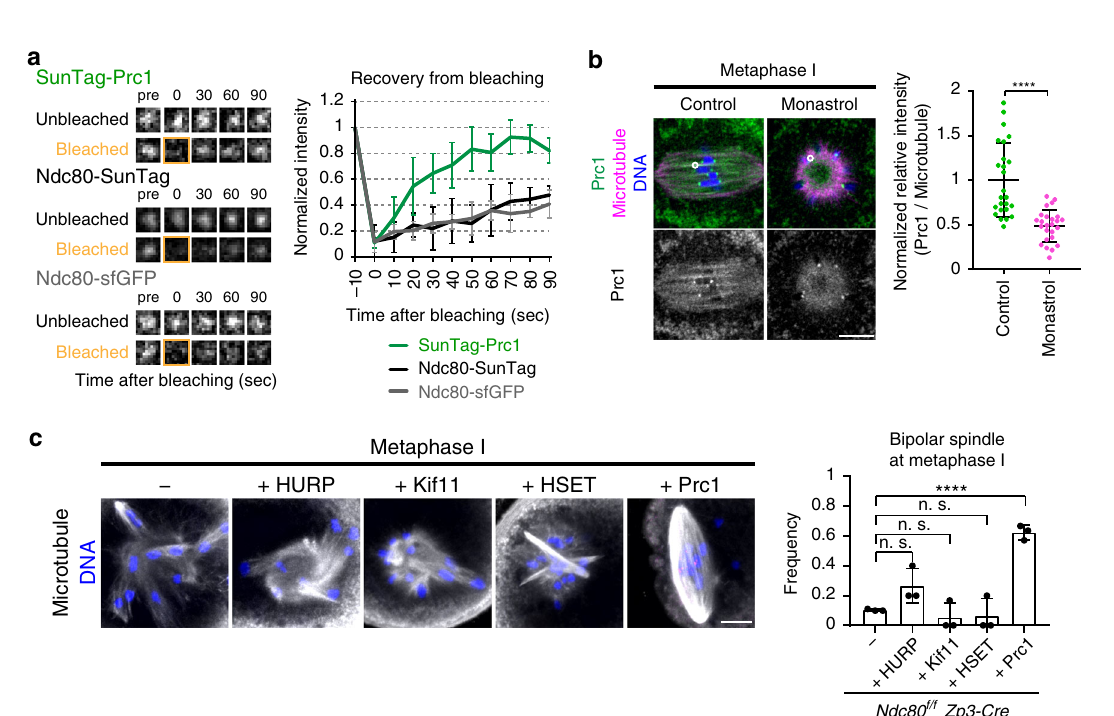
Fig. 5 Ndc80/Nuf2 concentrates dynamic Prc1 at kinetochores for spindle bipolarization. a Dynamic exchange of Prc1 at kinetochores. In oocytes at prometaphase I (1.5 h after NEBD), SunTag-Prc1 (24xGCN4-Prc1 coexpressed with scFv-sfGFP, green) signals at kinetochores were bleached, and the recovery was monitored ( n = 5, 5, 5 kinetochores). Note that the recovery curve of SunTag-Prc1 signals indicates the turnover of Prc1 at kinetochores rather than the turnover of scFv on 24xGCN4 in this time range, which was con fi rmed by Ndc80-SunTag (Ndc80-24xGCN4 coexpressed with scFv-sfGFP) exhibiting similar recovery curves to Ndc80-sfGFP. See also Supplementary Movie 7. b Kif11-dependent Prc1 enrichment along kinetochore-proximal microtubules of the bipolar spindle. Control or monastrol-treated oocytes at metaphase I (4 – 6 h after NEBD) were stained for Prc1 (green), microtubules (magenta), and DNA (Hoechst33342, blue). The oocytes were treated with a cold buffer for 1 min before fi xation to facilitate antibody penetration into the spindle. Prc1 signals along kinetochore-proximal microtubule bundles were measured, and their ratio to microtubule signals was calculated ( n = 25, 25 locations from 5, 5 oocytes. Three independent experiments were performed). **** p < 0.0001 ( p = 8.1E − 07) by two-tailed unpaired Student ’ s t -test. c Prc1 overexpression rescues spindle defects in Ndc80- deleted oocytes. Ndc80 f/f Zp3-Cre oocytes overexpressing mEGFP-HURP, mEGFP-Kif11, mNeonGreen- HSET, or mNeonGreen-Prc1 were immunostained at metaphase I (5.5 h after NEBD). Spindle shapes were reconstructed in 3D and categorized ( n = 29, 18, 18, 18, 24 oocytes from three independent experiments). **** p < 0.0001 ( p = 5.1E − 05) by two-tailed unpaired Student ’ s t -test. n.s., not signi fi cant. Scale bars, 10 μ m. Mean + / − SD are presented in a – c microtubule crosslinking helps kinetochores bind laterally to microtubule bundles. Such lateral kinetochore – microtubule to spindle bipolarization. The microtubule-binding domains attachments are predominantly observed during spindle bipo- appear to increase the local concentration of microtubules around larization and develop into stable end-on attachments by the kinetochores, which may locally facilitate Prc1-mediated marking onset of anaphase I in mouse oocytes 59 – 63 . In either case, kine- of antiparallel microtubule overlaps. Another possibility is that kinetochore enrichment of Prc1-dependent antiparallel tochores act as a scaffold to increase the local concentration of